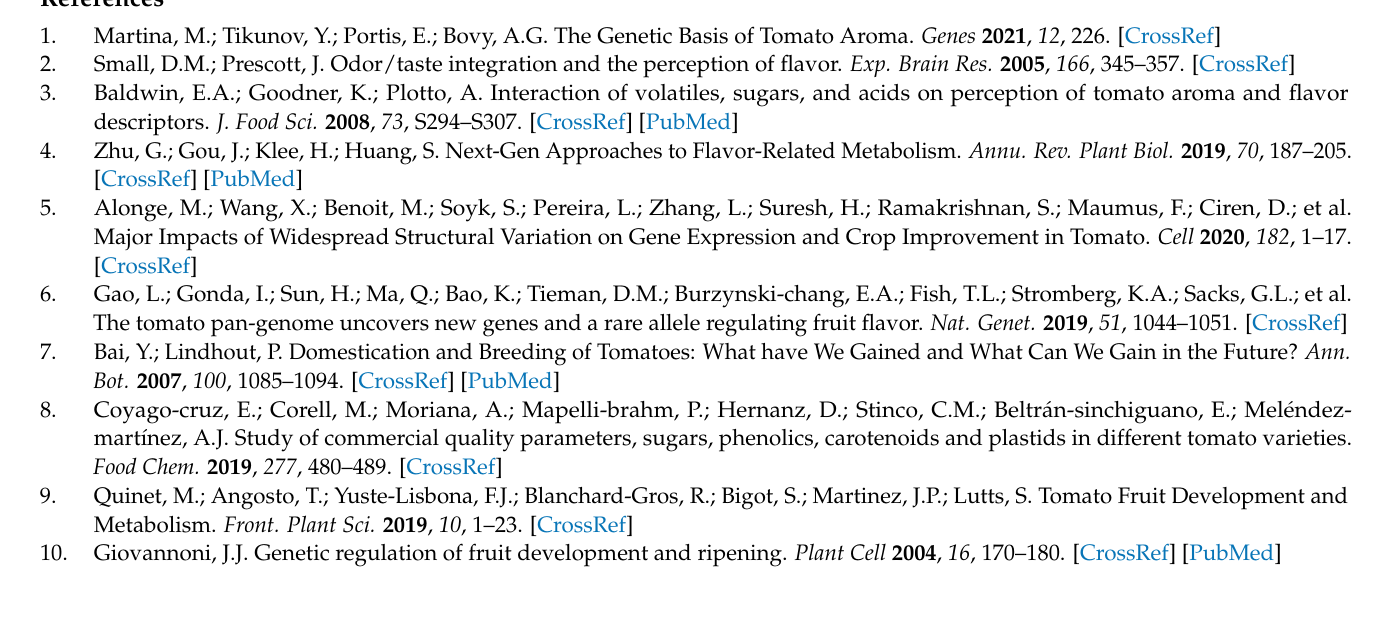
Figure S4: Comparison of soluble solids content in high and low chlorophyll varieties, Figure S5: Comparison of amount of the four pigments in fruits of “Dixie Golden Giant,” “Kellogg’s Breakfast,” and “Ailsa Craig.”, Figure S6: UV spectra of peak No.9 and all- trans -lycopene, Table S1: The pigment content in fruits of the 157 varieties, Table S2: Technical error validation of the pigment profiling using microplate reader applied with the developed method, Table S3: Characteristics of the eight representative varieties used in the study, Table S4: Content of identified carotenoids in the eight tomato varieties using HPLC analysis, Table S5: Relative content and characteristics of unidentified carotenoids in selected tomato lines, Table S6: Gradient time program of HPLC analysis used in the